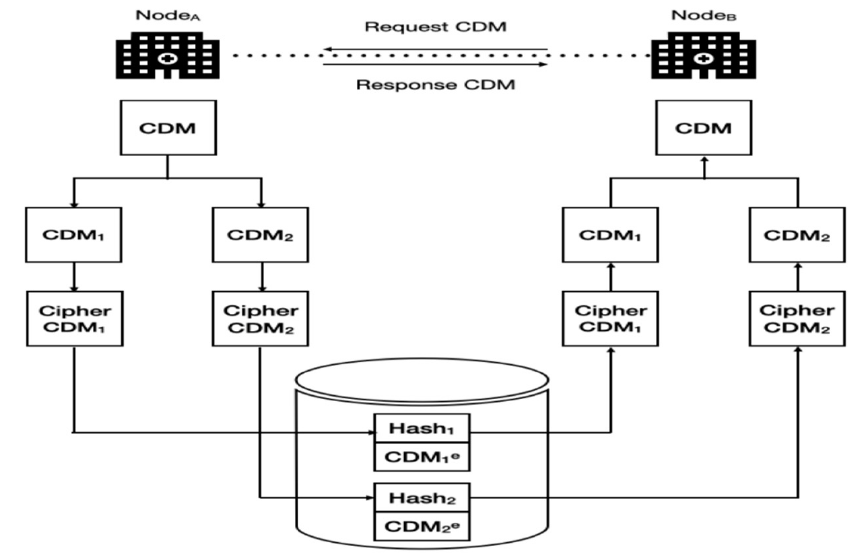
Figure 4. Sharing the encrypted CDM between nodes in SC-CDM .